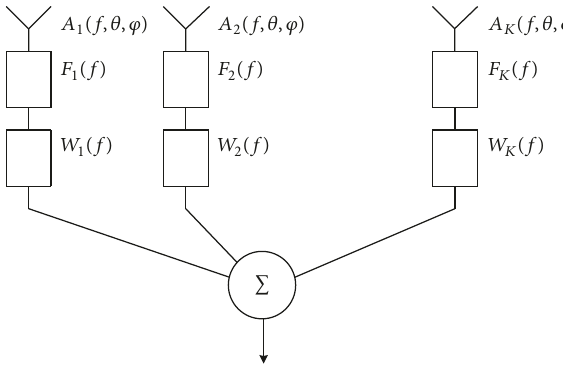
Figure 1: STAP-based adaptive antenna array